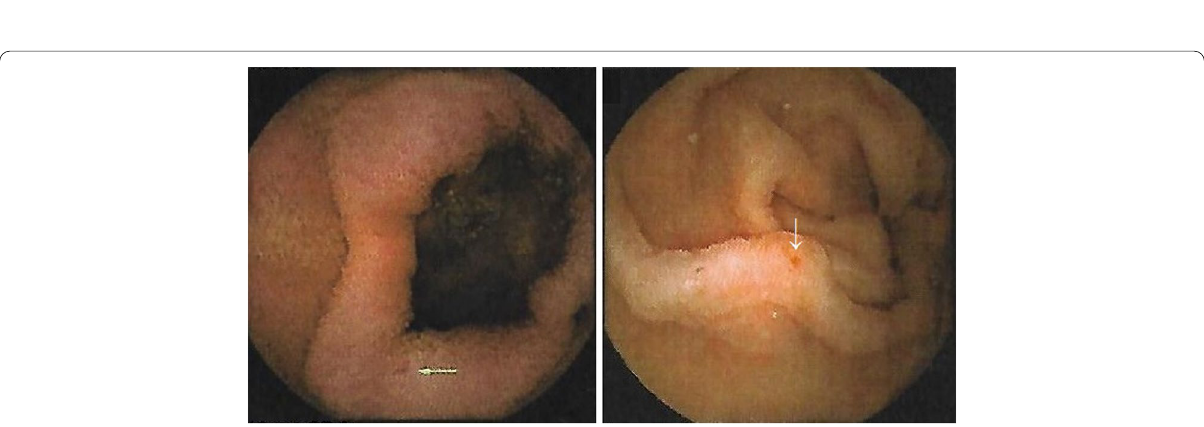
Fig. 4 Video Capsule Endoscopy image of jejunal